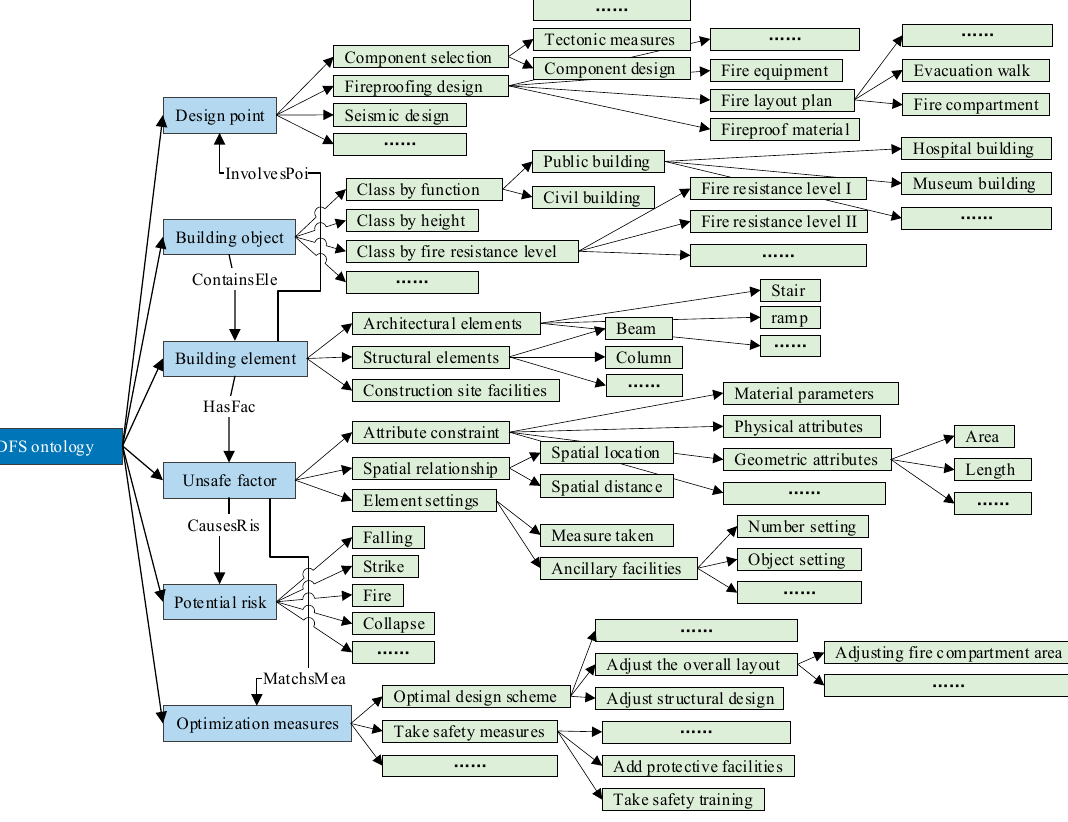
Figure 7. Generation of the hierarchical DFS ontology.